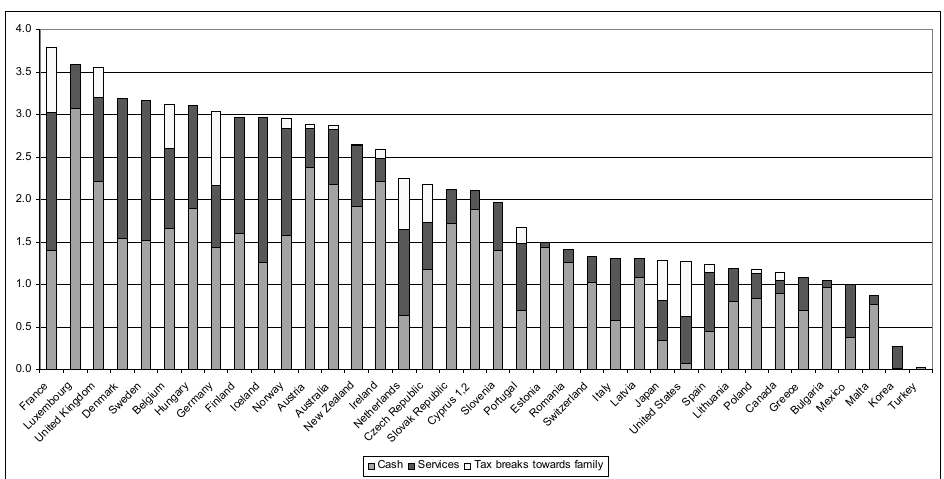
Figure 13 : Family spending in cash, services and tax measures, in percentage of GDP, in